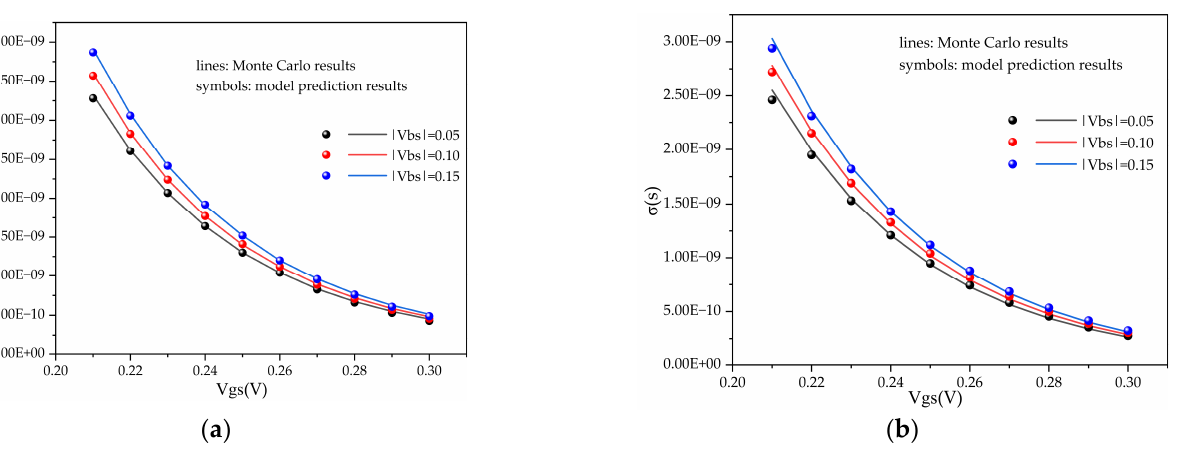
Figure 12. Model prediction results compared with the MC simulation results (T = 25 °C, Cl = 0.7 fF, τ = 2 × 10 −10 s) considering the body effect under different voltages. ( a ) Mean of the delay; ( b ) standard deviation of the delay.